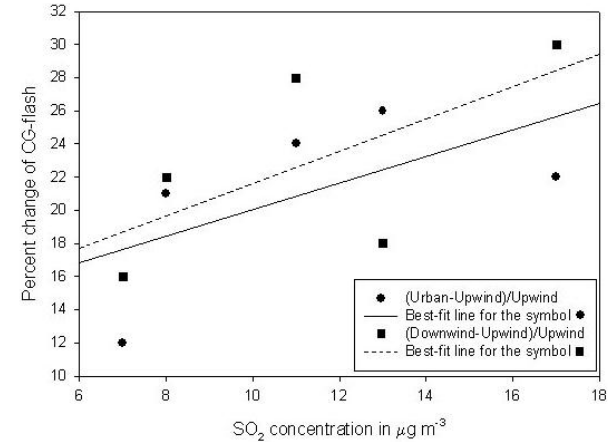
Fig. 5. Scatter plot and best-fit line of percent change in the number of CG flashes and annual averages of PM 10 concentrations for the years 1995–1999.